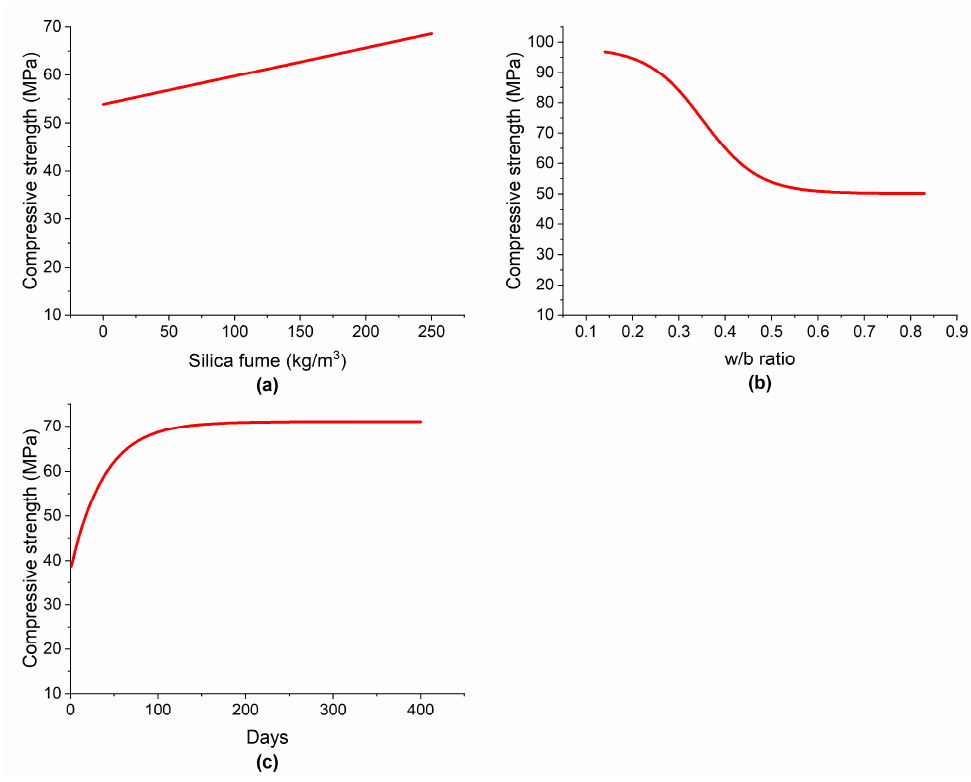
Figure 10. Variation in the CS by changing: ( a ) silica fume; ( b ) w/b ratio; ( c ) curing time.